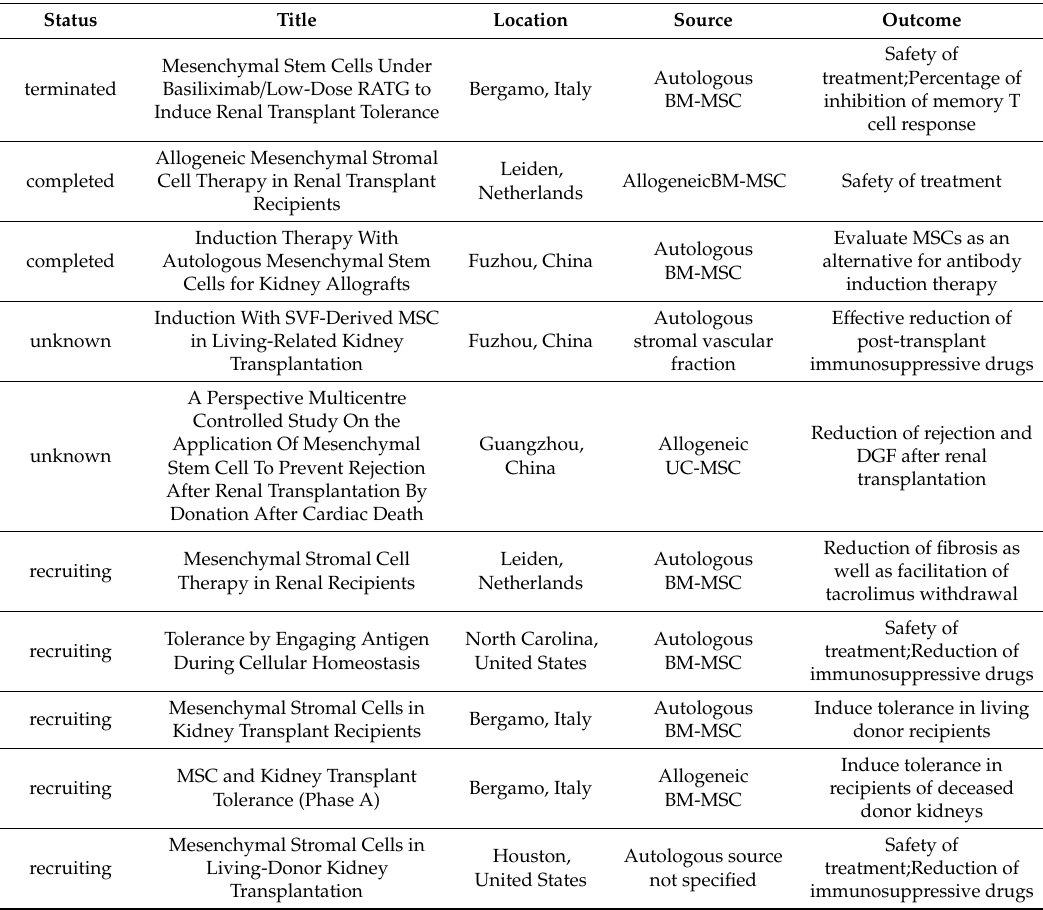
Table 1. The 10 registered clinical trials on the subject of mesenchymal stem / stromal cell therapy in kidney transplantation (clinicaltrials.gov–accessed 12 September 2019). MSCs: mesenchymal stromal cells, BM-MSC: bone marrow MSC, UC-MSC: umbilical cord MSC, DGF: delayed graft failure, RATG: rabbit-antithymocyte-globulin, SVF: stromal vascular